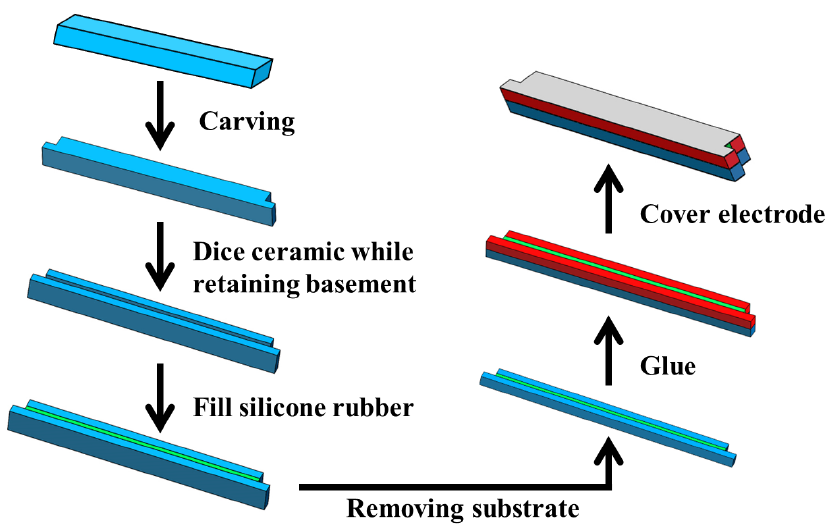
Figure 8. The preparation process of the double-harmonic piezoelectric composite lamination.